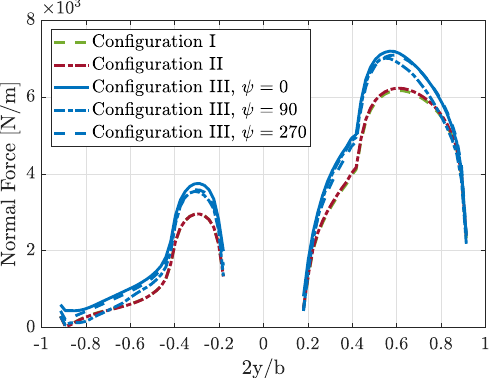
Figure 20. Span-wise normal force distribution on the wing at bank angle φ = 30°.